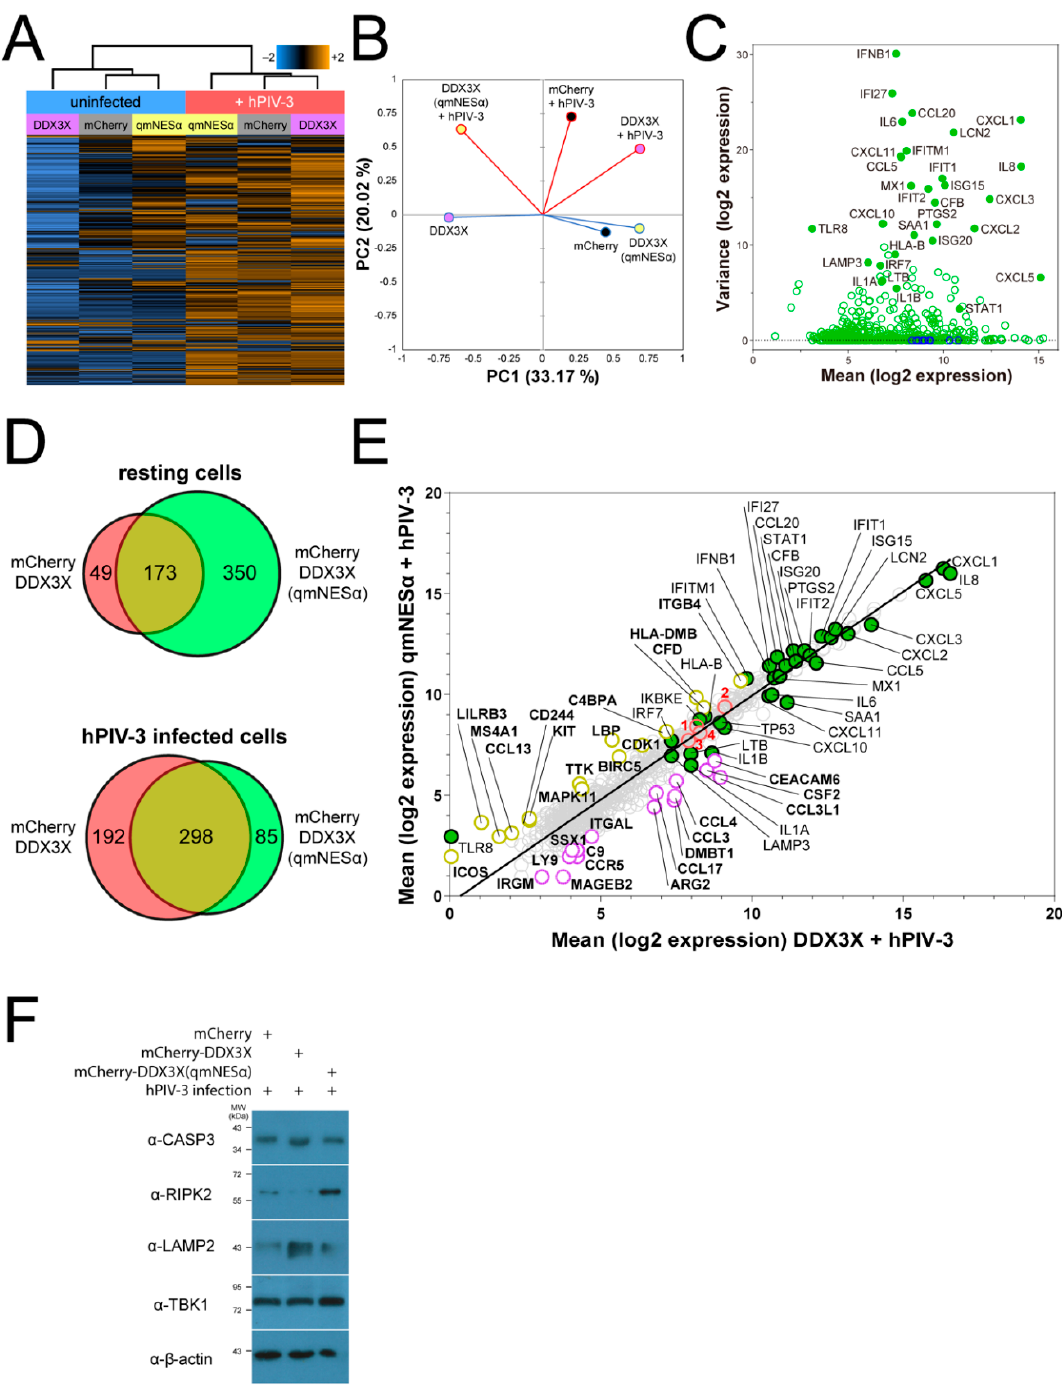
Figure 6. Lack of DDX3X nuclear export impacts steady-state and virus-induced transcription profiles and interferon-induced antiviral responses. NanoString transcriptional profiling was performed for A549 cells stably overexpressing mCherry-DDX3X, mCherry-DDX3X(qmNES α ), or mCherry alone and infected with or without hPIV-3 for 24 h. ( A ) Cluster heatmap of Pearson correlation averaged log 2 -normalized levels of all 730 gene transcripts. Relative RNA levels are plotted as z-scores using the indicated color heatmap (blue = decrease, orange = increase, black = no change). ( b ) Pearson correlation principal component analysis of transcription data from panel A. Lines denote infection